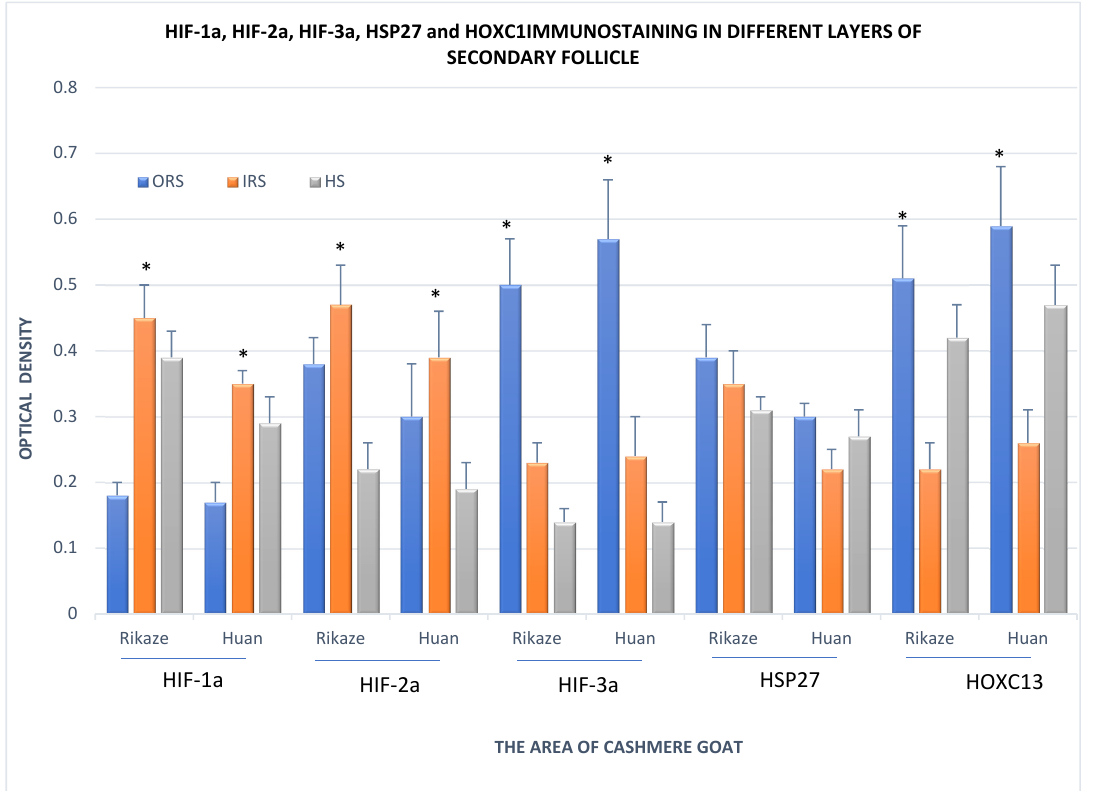
Figure 5. Immunostaining of HIF-1a, HIF-2a, HIF-3a, HSP27, and HOXC13 in outer root sheath, inner root sheath, and hair shaft of the secondary hair follicle in the Tibetan cashmere goat. Values are means ± SD ( n = 12). Red bars indicate the outer root sheath, orange bars the inner root sheath, and yellow bars the hair shaft. Rikaze indicates the goats lived in the Rikaze Province while Huan indicates the goats were from Huan County. * Indicates the presence of significant differences ( p < 0.05) in the IOD values between goats from Rikaze and goats from Huan in that protein in that layer of the secondary